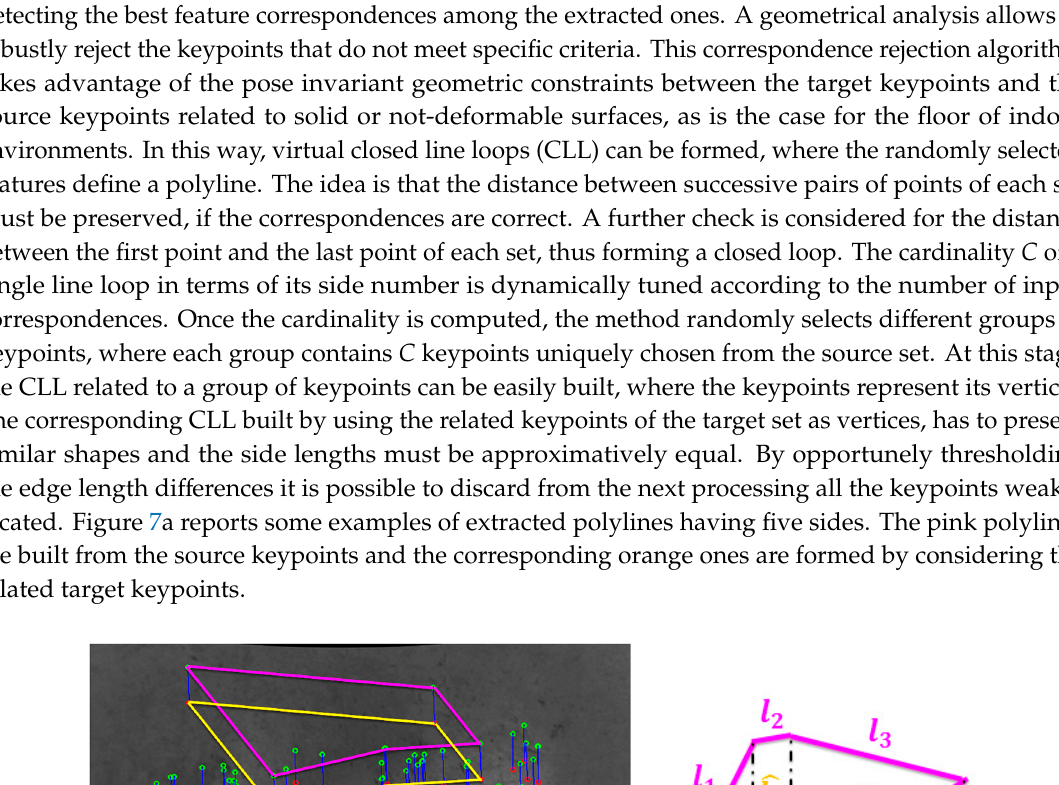
Figure 8. ( a ) Rejected and ( b ) good correspondences by applying the geometric invariance check approach. The parameter t is set to 0.85 and a cardinality C equal to three is considered. ( a )